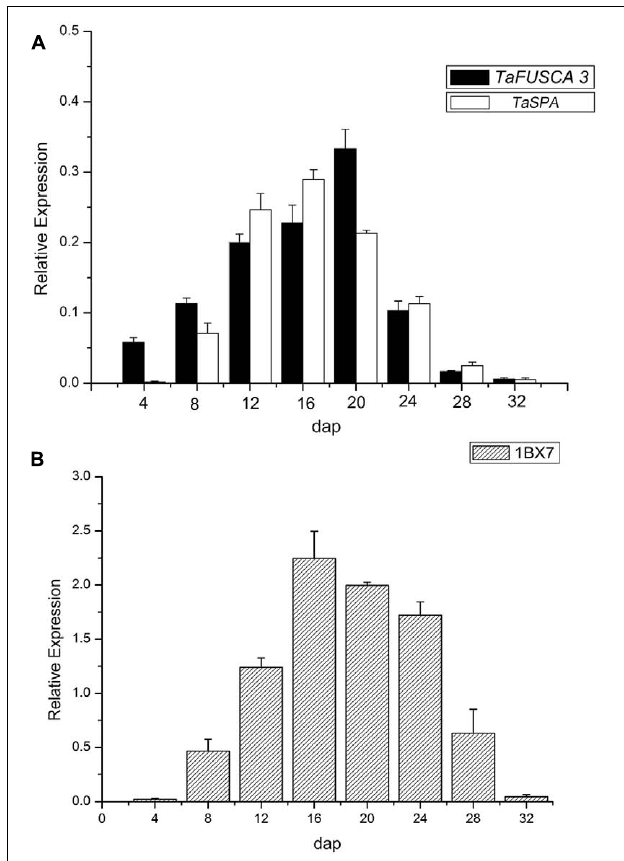
FIGURE 5 | TaFUSCA3 recombined with GST protein was expressed in prokaryotic expressive E. coli strain BL21. (A) SDS-PAGE of fusion proteins isolated from the prokaryotic expression system. (1) Total proteins of strain BL21 with GST before isopropyl β - D -1-thiogalactopyranoside (IPTG) induction. (2) Total proteins of strain BL21 with GST after IPTG induction. (3) Total proteins of strain BL21 with fusion protein TaFUSCA3-GST before IPTG induction. (4) Total proteins of strain BL21 with fusion protein TaFUSCA3-GST after IPTG induction. (5) Total supernatant fluid proteins of strain BL21 with fusion protein TaFUSCA3-GST after IPTG induction. (6) Total precipitated proteins of strain BL21 with fusion protein TaFUSCA3-GST after IPTG induction. (7) Purified proteins of strain BL21 with fusion protein TaFUSCA3-GST after IPTG induction. Arrow represents the fusion protein TaFUSCA3-GST. (B) Western blotting verified the results of fusion protein TaFUSCA3-GST isolated from the prokaryotic expression system. (1) Total proteins of strain BL21 with fusion protein TaFUSCA3-GST after IPTG induction. (2) Total supernatant fluid proteins of strain BL21 with fusion protein TaFUSCA3-GST after IPTG induction. (3) Total precipitated proteins of strain BL21 with fusion protein TaFUSCA3-GST after IPTG induction. (4) Purified proteins of strain BL21 with fusion protein TaFUSCA3-GST after IPTG